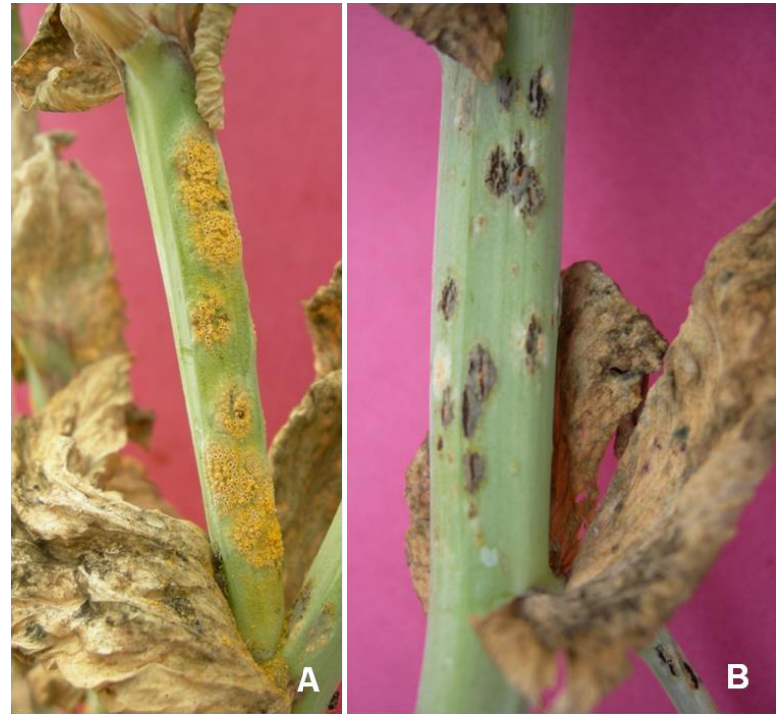
Figure 3. ( A ) Uredial and ( B ) telial pustules on stems of pea infected by U. viciae-fabae